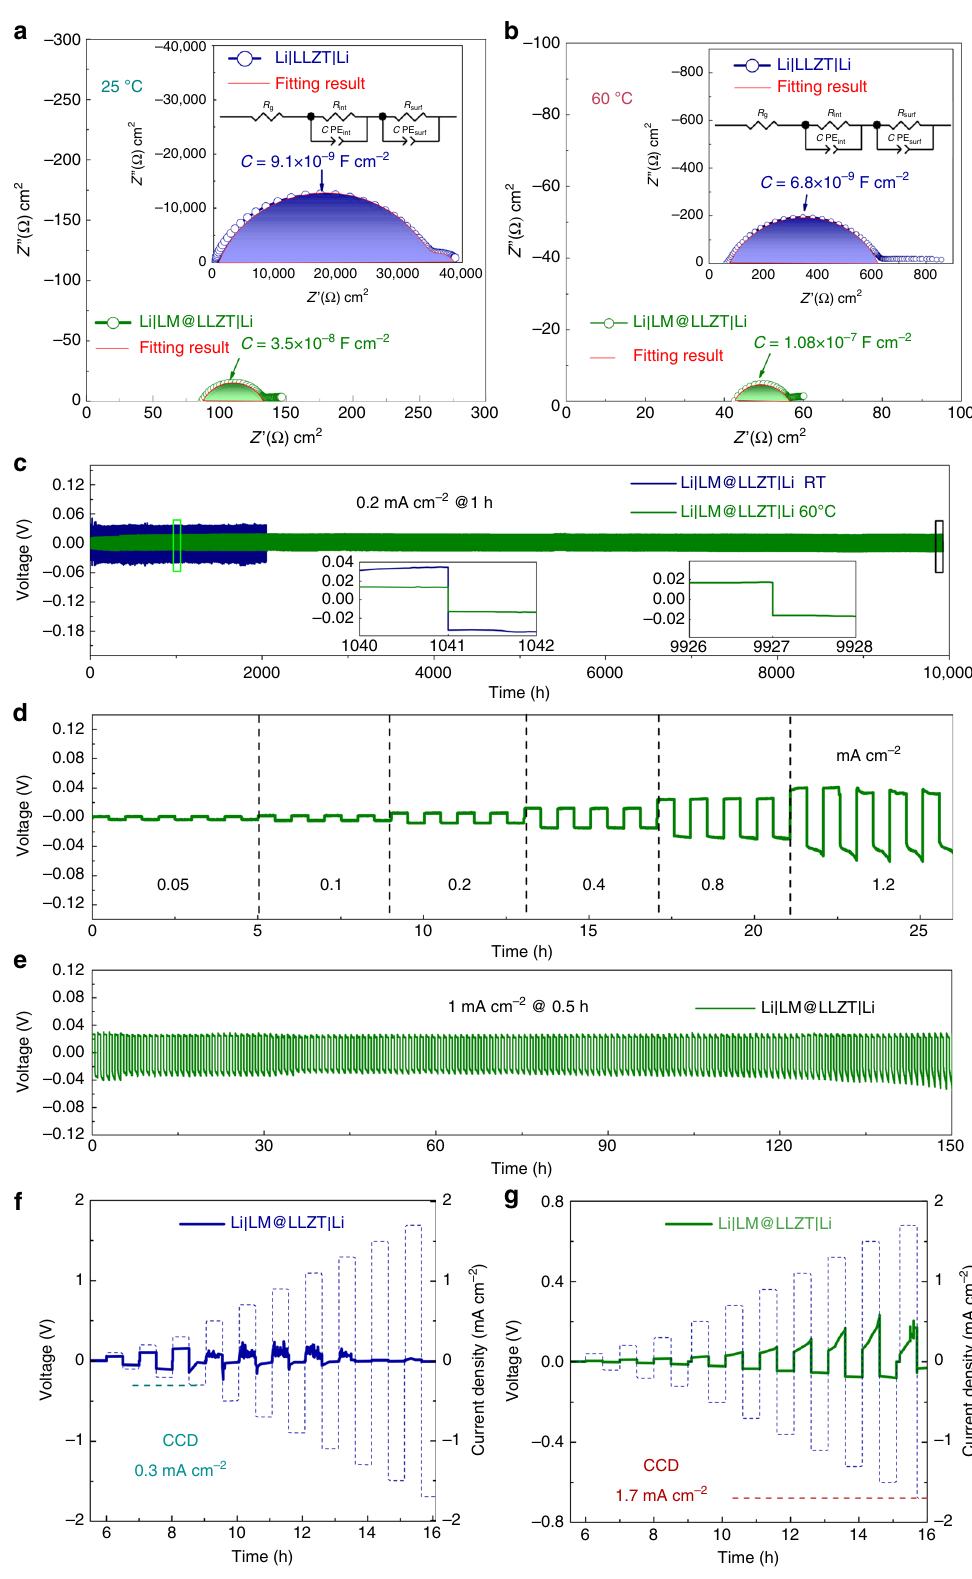
Fig. 4 Electrochemistry of Li/Li symmetric cells based on LM-wetted garnet. Electrochemical impedance spectra of Li|LM@LLZT|Li symmetric cells at ( a ) room temperature and ( b ) 60 °C. Insets: corresponding impedance spectra of Li|LLZT|Li symmetric cells without any modi fi cation. c Long-term performance of Li|LM@LLZT|Li symmetric cells at 0.2 mA cm − 2 at room temperature and 60 °C. Insets: corresponding voltage pro fi les at different cycling stages. d Rate performance of Li|LM@LLZT|Li symmetric cell from 0.05 to 1.2 mA cm − 2 . e Li plating-stripping performance Li|LM@LLZT|Li symmetric cell at a high current density of 1 mA cm − 2 . Critical current density measurement of Li/Li symmetric cells based on ( f ) unmodi fi ed garnet (with 10 uL of liquid electrolyte adding) and based on ( g ) liquid metal painted